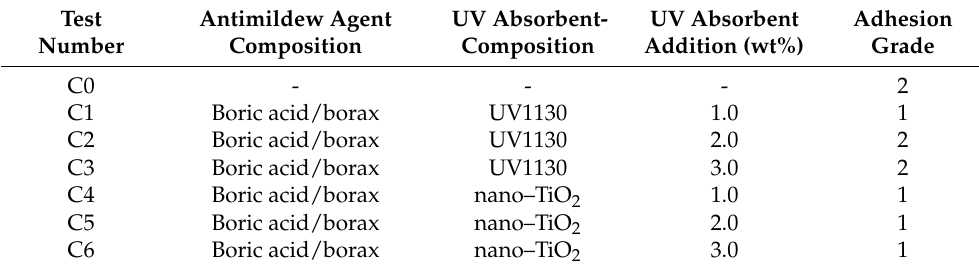
Table 4. Adhesion grades of the coatings with different weathering